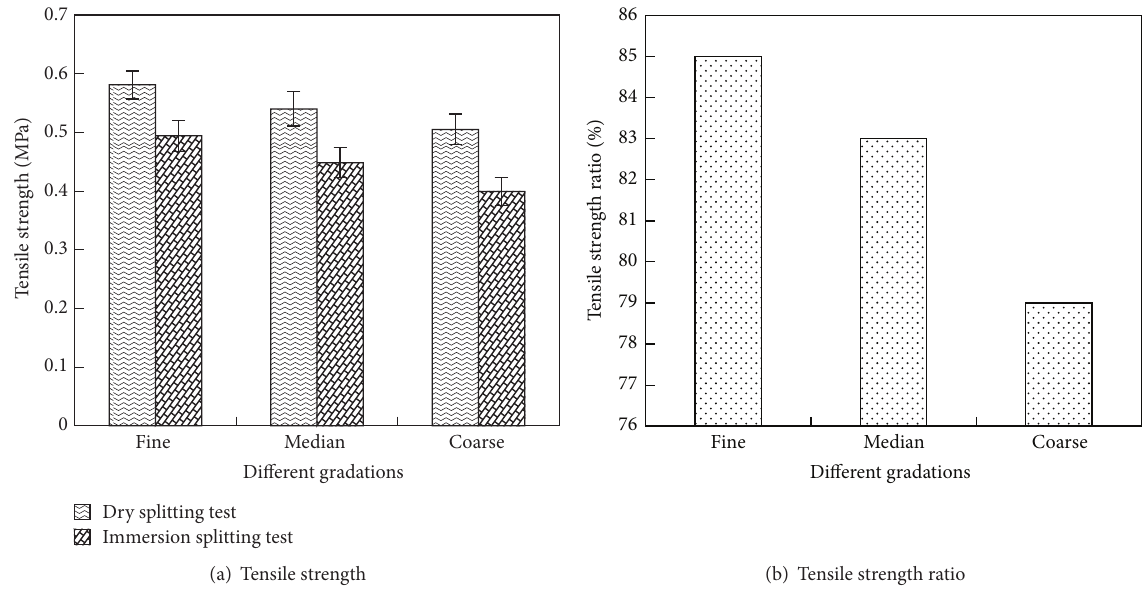
Figure 5: Splitting test results for cold recycled asphalt mixtures with different